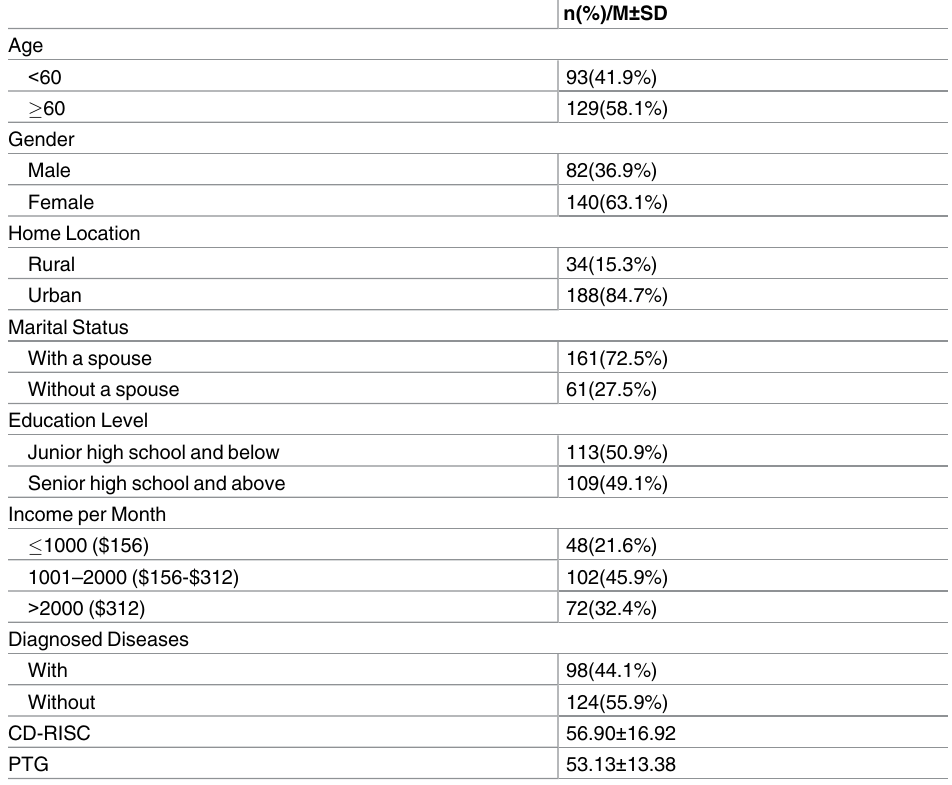
Table 1. Sociodemographic and clinical characteristics of the